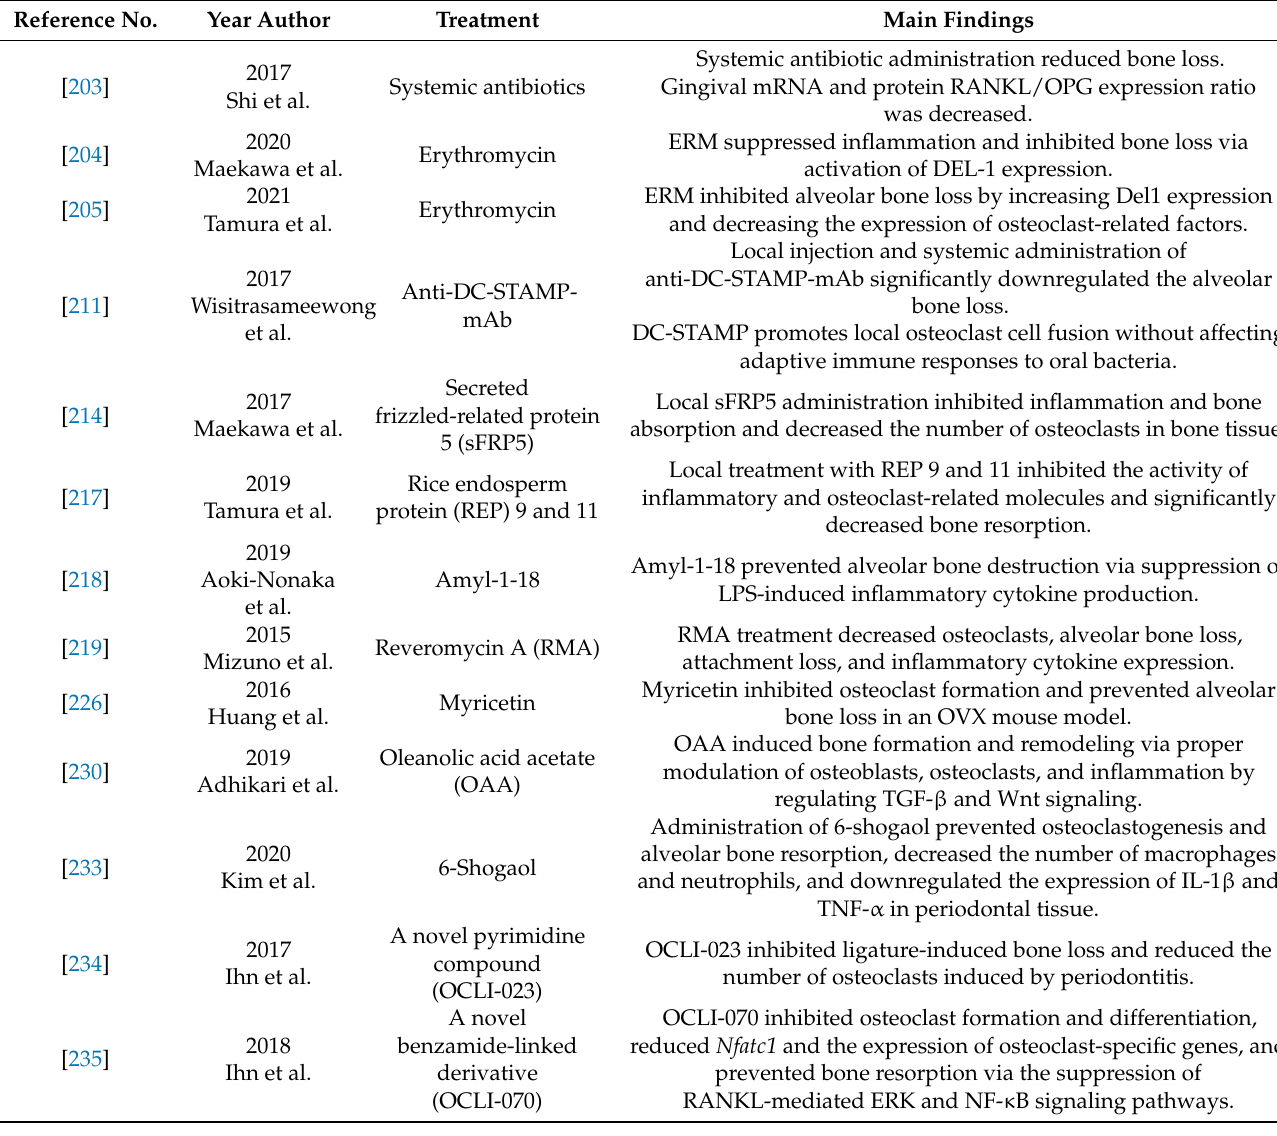
Table 9. Summary of the effect of new treatment methods in ligature-induced periodontitis. Reference